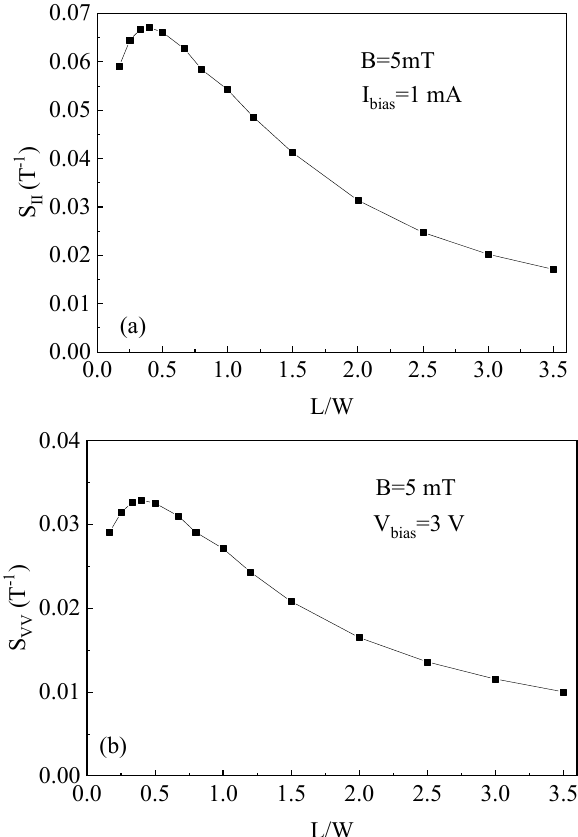
Figure 7. Simulated sensitivity versus different L/W ratios of the cross-like Hall plate. ( a ) current-mode, ( b ) voltage-mode.